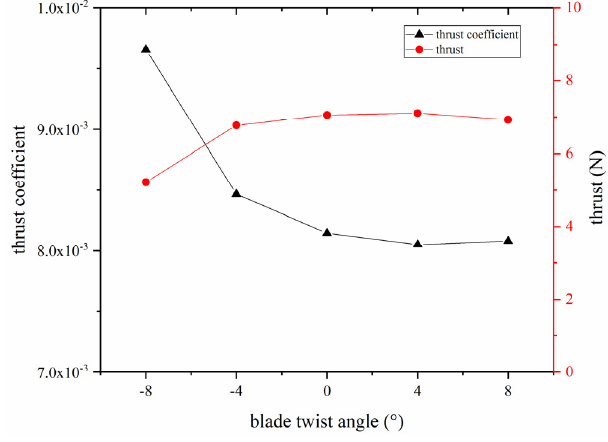
Figure 22. The thrust and thrust coefficient with blade twist angle.